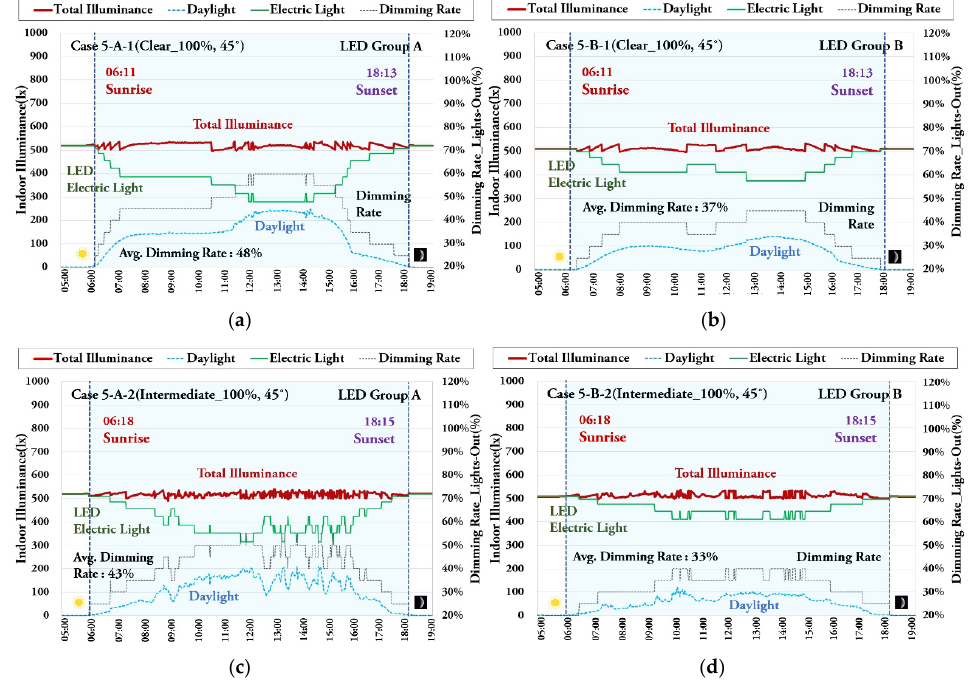
Figure 17. Illuminance and dimming rates under dimming controls integrated with manual blind controls (Blind VP 100%, Slat angle 45°) (clear sky_09.09 and intermediate sky_09.12). ( a ) Case 5-A-1, ( b ) Case 5-B-1, ( c ) Case 5-A-2, and ( d ) Case 5-B-2 in Table 6.